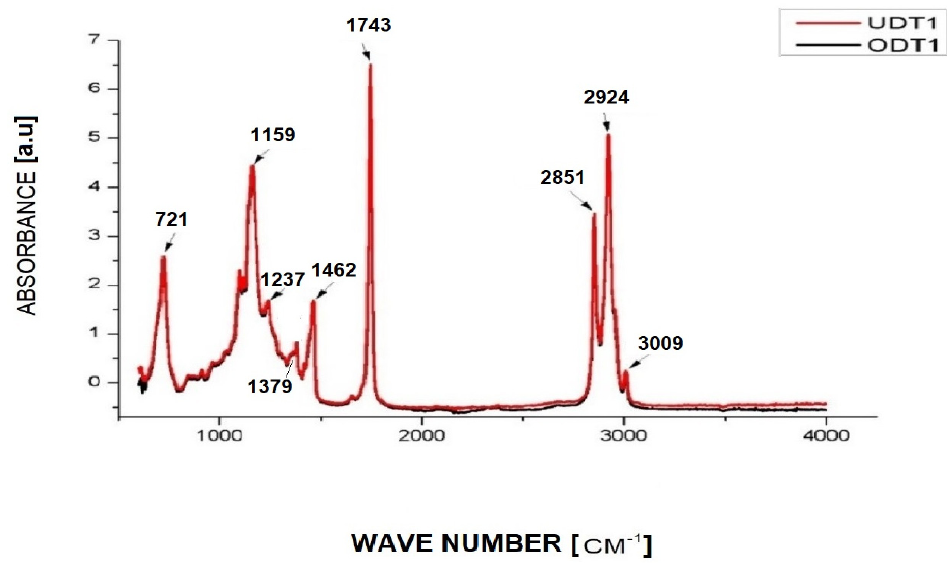
Figure 2. FTIR raw spectra of pumpkin seed oil (UDT1) and oleogel (ODT1) in fresh state (T1).